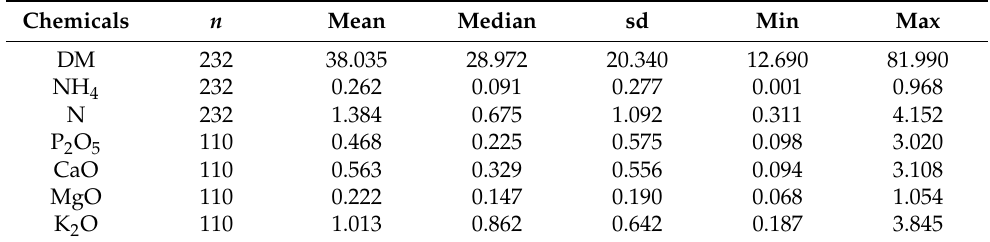
Figure 3. Near ‐ infrared spectra after standardization (mean = 0, standard deviation = 1) and Savitzky ‐ Golay smoothing of fresh homogenized cattle and poultry manure samples as shown in different line colors. Table 2. Descriptive statistics of the chemical components of poultry and cattle manure in fresh- weight basis (%) of the 232 (for dry matter (DM), total ammonium nitrogen (NH 4 ), and total nitrogen (N)) and 110 (for P 2 O 5 , CaO, MgO, and K 2 O) samples for the training set. ( n = number of samples, sd = standard deviation, min = minimum value, max = maximum value.)